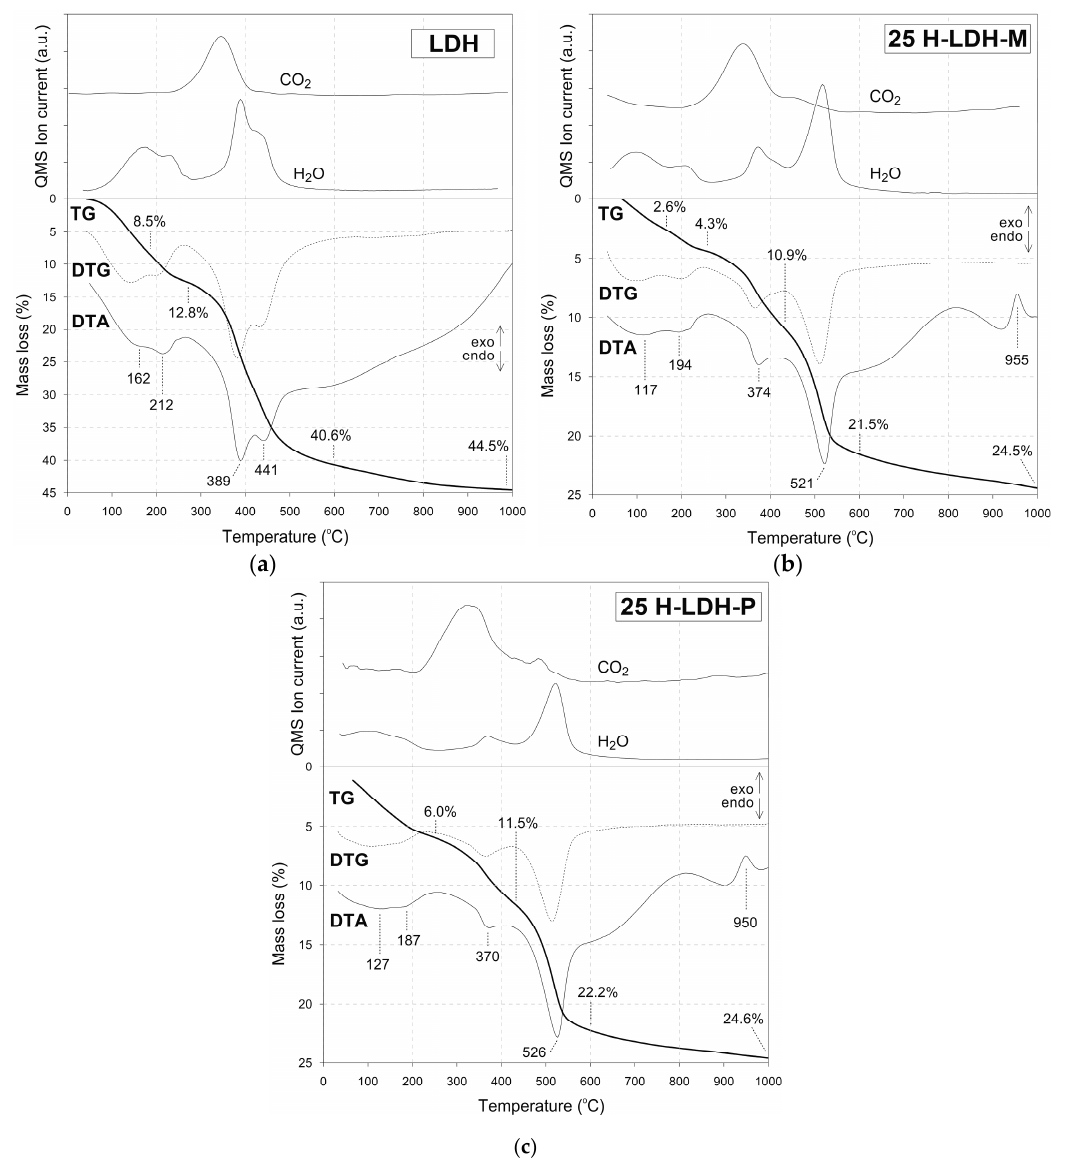
Figure 4. Thermal curves of ( a ) LDH, ( b ) 25 H-LDH-P and ( c ) 25 H-LDH-M.